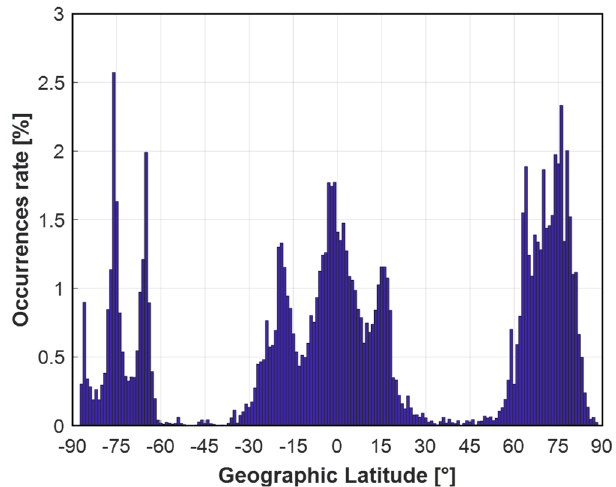
Figure 15. Distribution of ROTI values by latitude (only ROTI ≥ 0.5 TECU/min are counted). It can be seen that ionospheric irregularities are mainly concentrated in the equatorial and high-latitude regions but rarely occur in the mid-latitude areas. In the low-latitude areas, ionospheric irregularities tend to appear symmetrically over the equator, while in the high-latitude regions in the Northern Hemisphere, a higher number of ionospheric irregularities can be seen compared to the Southern Hemisphere.